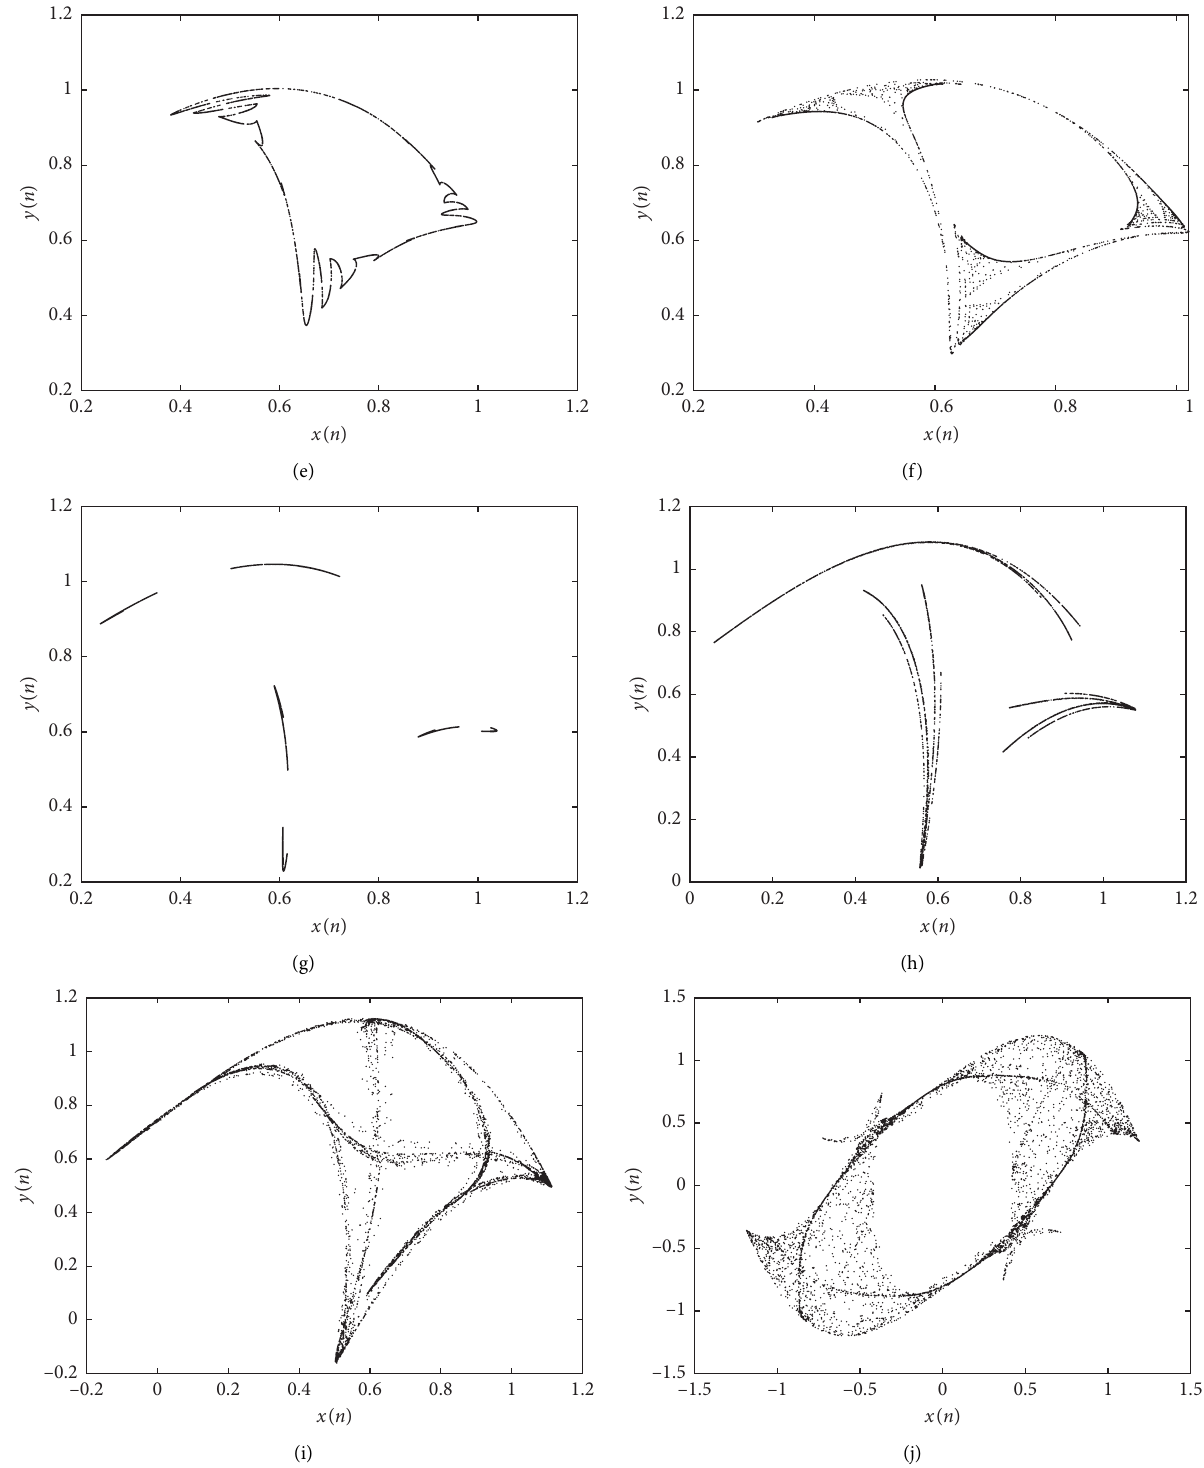
Figure 3: The phase diagrams of map (10) with the initial condition x with b � 1, (c) b � 1 . 5, (d) b � 1 . 6, (e) b � 1 . 7, (f) b � 1 . 75, (g) b � 1 . 8, (h) b � 1 . 9, (i) b � 2, and (j) b � 2 .